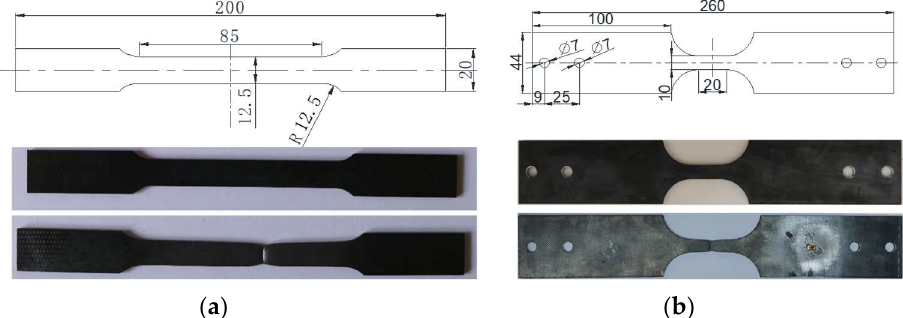
Figure 5. Dog-bone test specimens for ( a ) quasistatic tension and ( b ) dynamic tension (unit: mm).